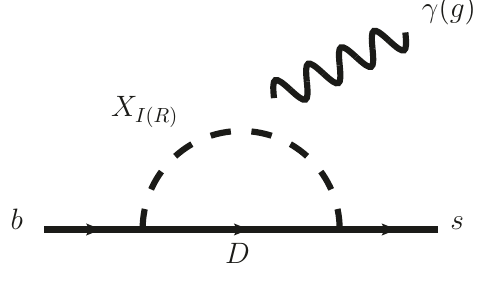
s(cid:13) ( g ). The photon (gluon) !